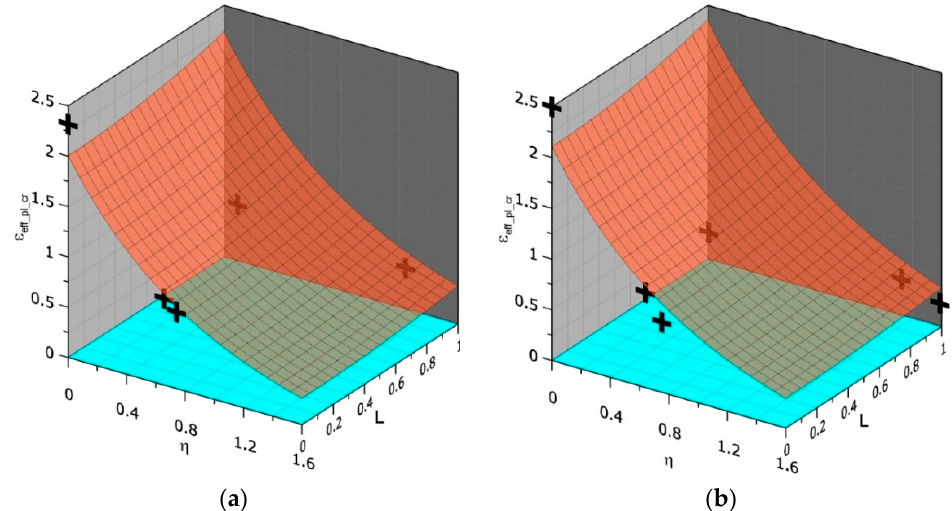
Figure 9. Three-dimensional dependence between η , L , and ε eff _ pl _ cr for ( a ) N material and ( b ) HW material. 5. Stress Distribution in Front of the Crack